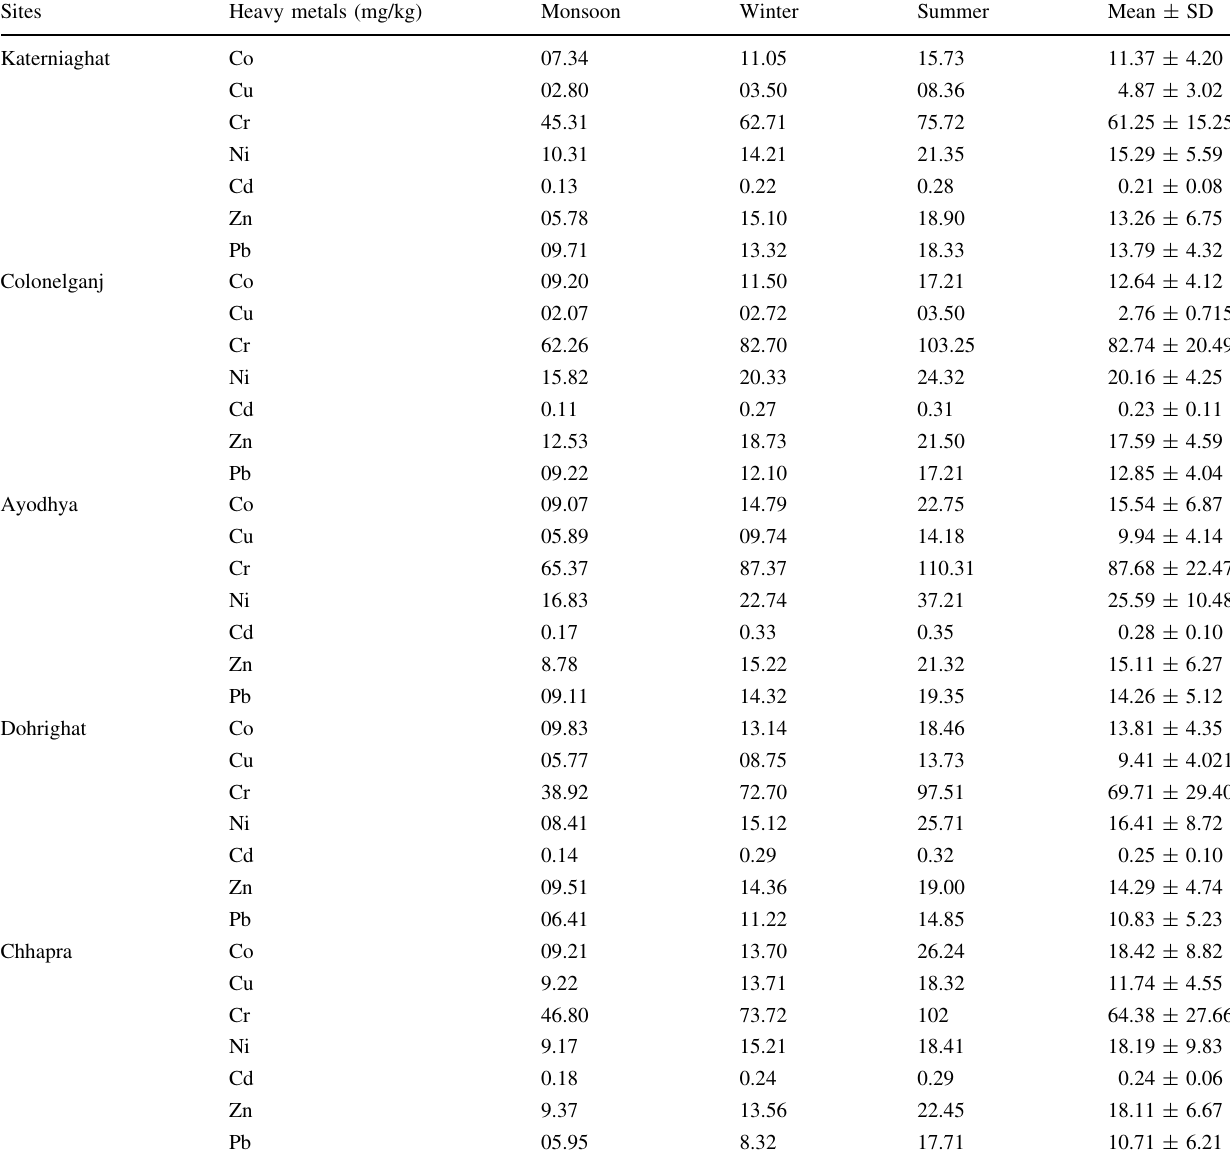
Table 2 Descriptive statistics of heavy metals ions present in sediment of river Ghaghara